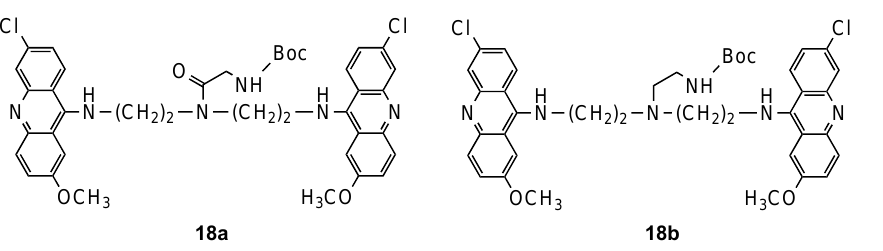
Figure 12. Compounds 18 developed by Girault and co-workers [27].